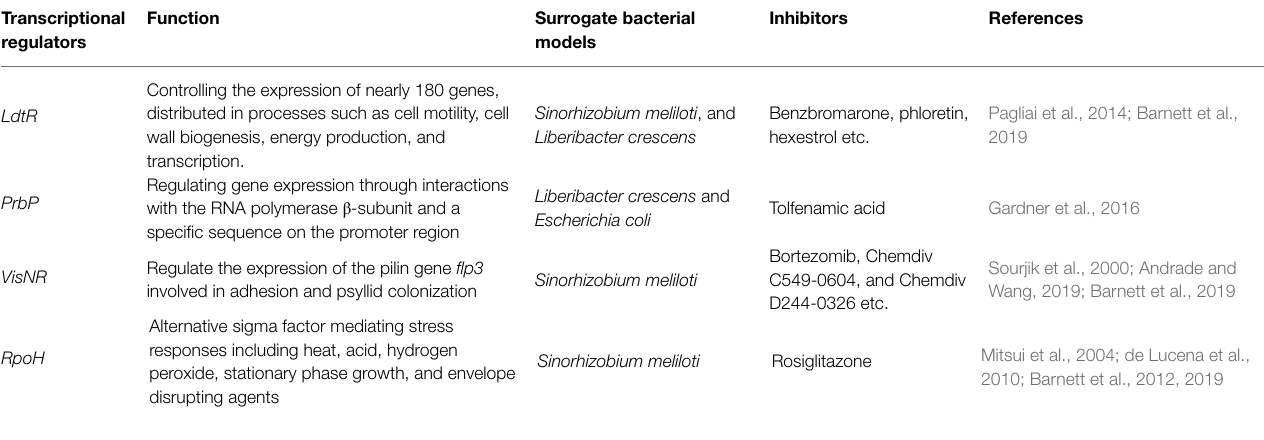
TABLE 1 | Transcriptional regulators in uncultured bacteria Candidatus Liberibacter and inhibitors found in surrogate models for screening chemicals targeted the gene. Transcriptional